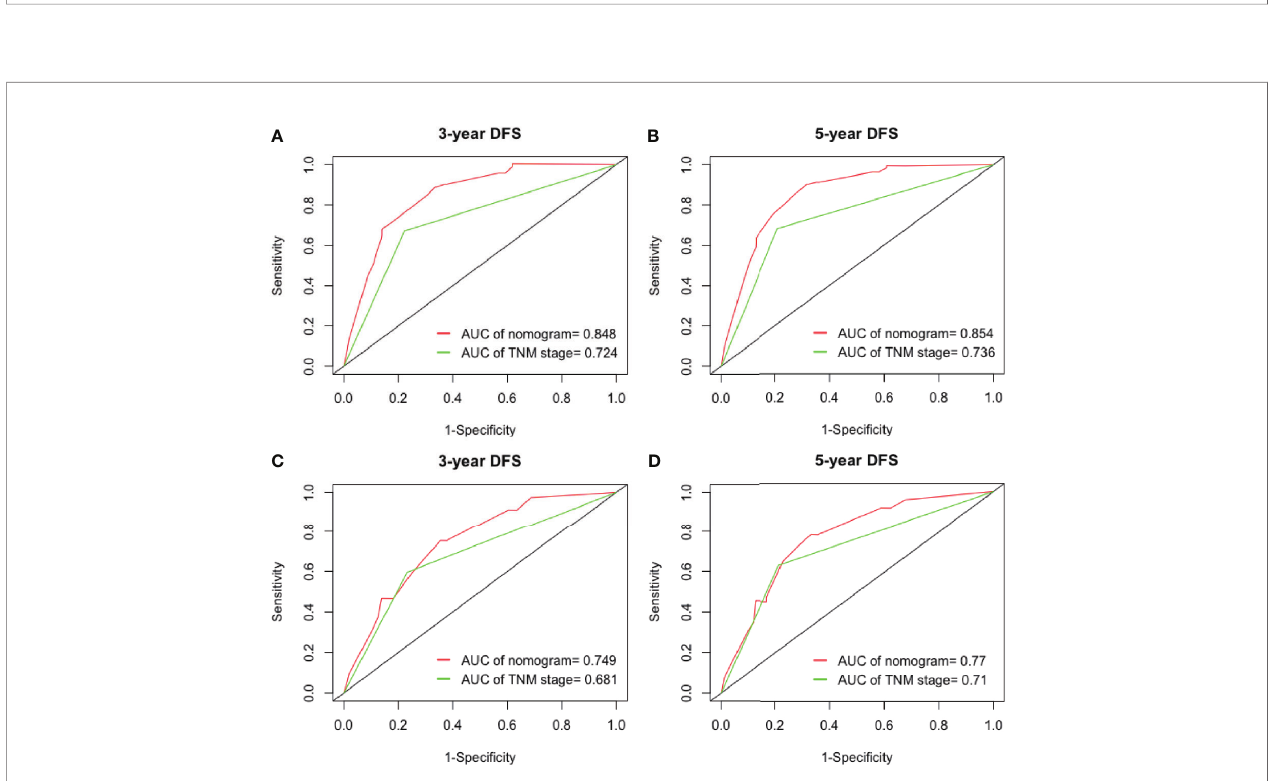
FIGURE 6 | The ability of ROC analysis of nomogram to predict the (A) 3-year and (B) 5-year DFS rate in the training cohort; (C) 3-year and (D) 5-year DFS rate in the validation cohort. ROC, receiver operating characteristic; DFS, disease-free